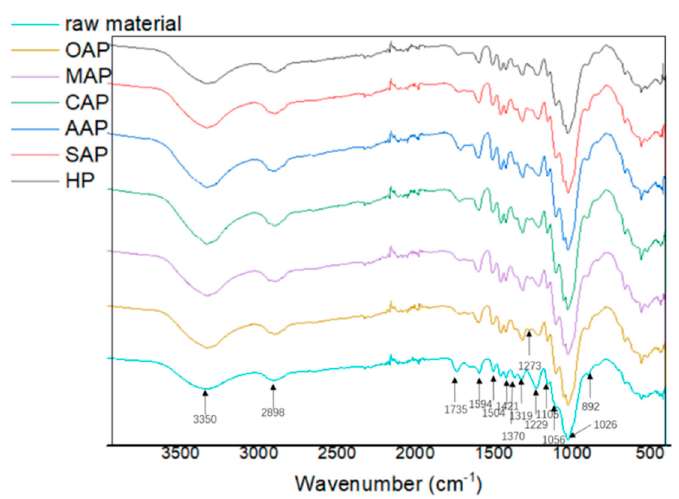
Figure 1. The Fourier transform infrared spectroscopy (FTIR) spectra of raw material and pretreated eucalyptus.